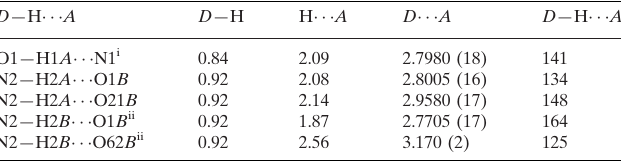
Data collection: CrysAlis Pro (Oxford Diffraction, 2009); cell refinement: CrysAlis RED (Oxford Diffraction, 2009); data reduc- tion: CrysAlis RED ; program(s) used to solve structure: SHELXS97 (Sheldrick, 2008); program(s) used to refine structure: SHELXL97 (Sheldrick, 2008); molecular graphics: SHELXTL (Sheldrick, 2008); software used to prepare material for publication: SHELXTL